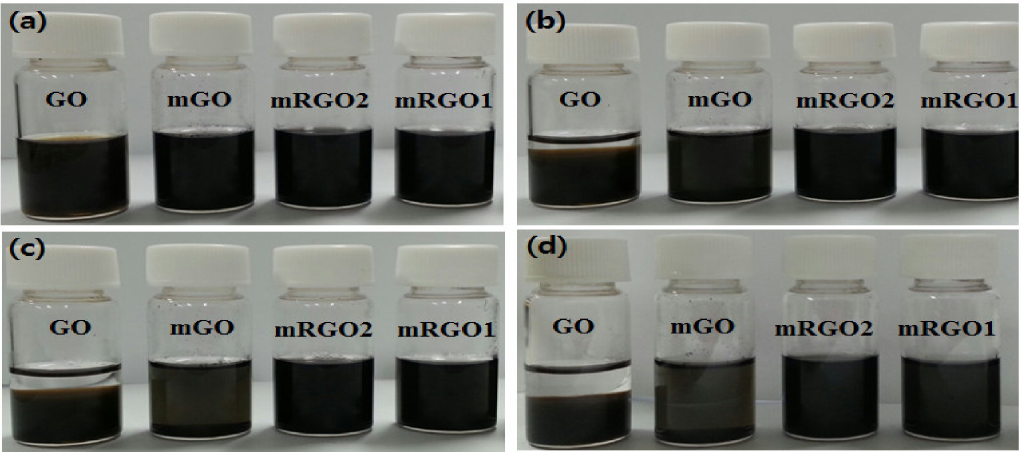
Figure 2. Colloidal suspensions of GO, mGO, mRGO2 and mRGO1 ( a ) just after sonication, ( b ) 18 h, ( c ) 48 h and ( d ) 144 h after